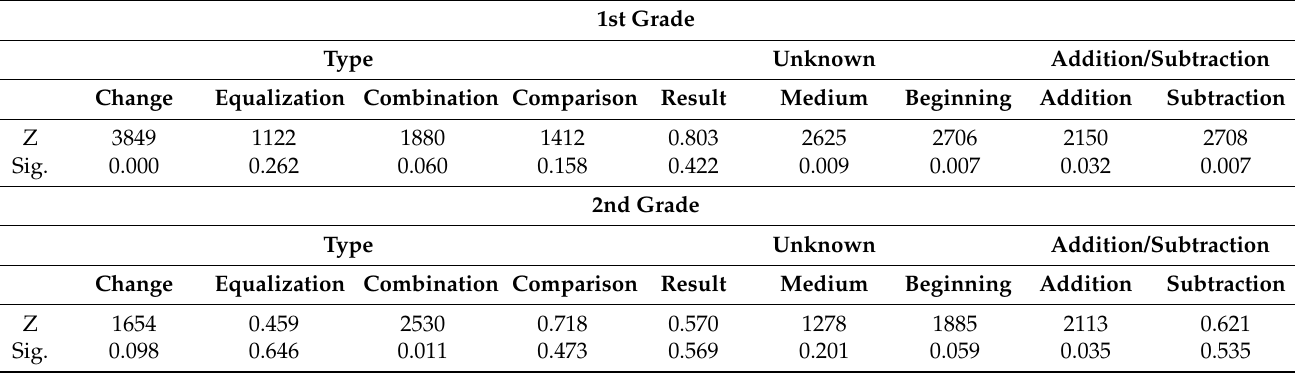
Table 7. Effects of the types of problems by language coincidence